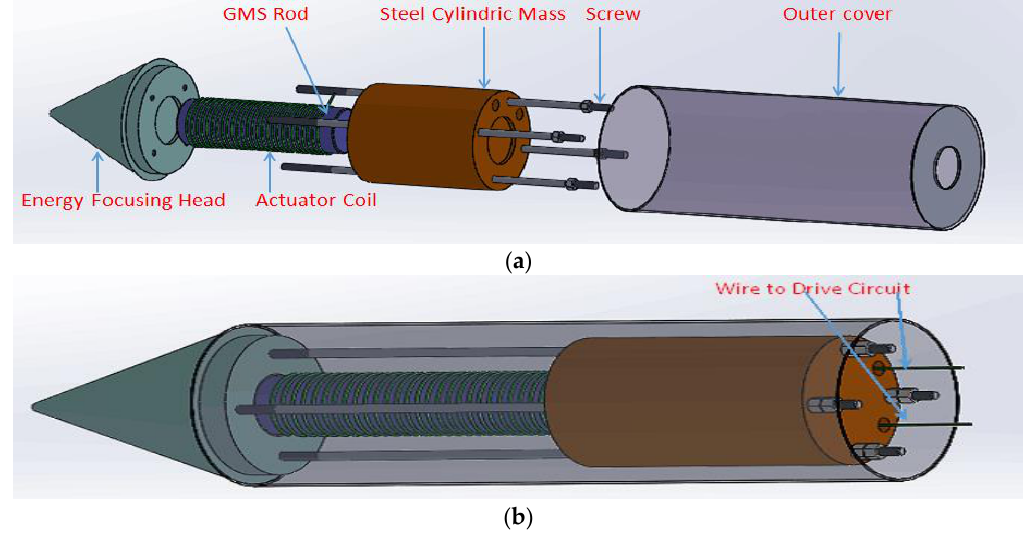
Figure 1. The giant magnetostrictive (GMS) actuator. ( a ) Components of the GMS actuator; ( b ) Assembled GMS actuator.